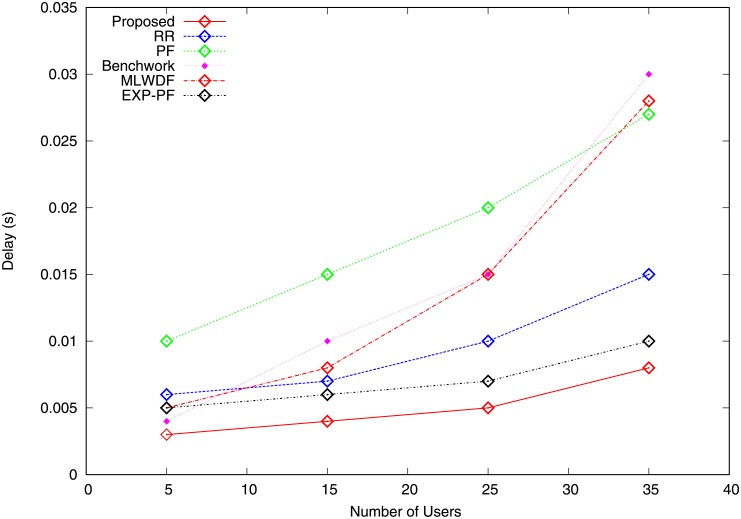
Delay video traffic.